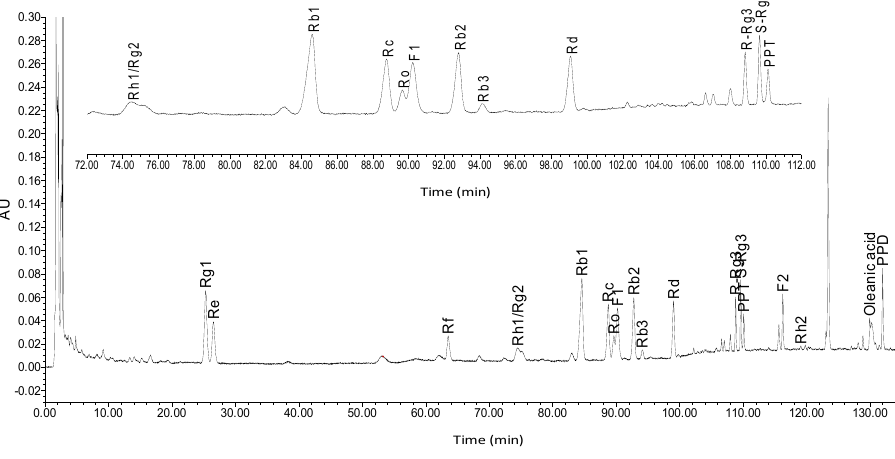
Figure 2. HPLC record of ginseng.